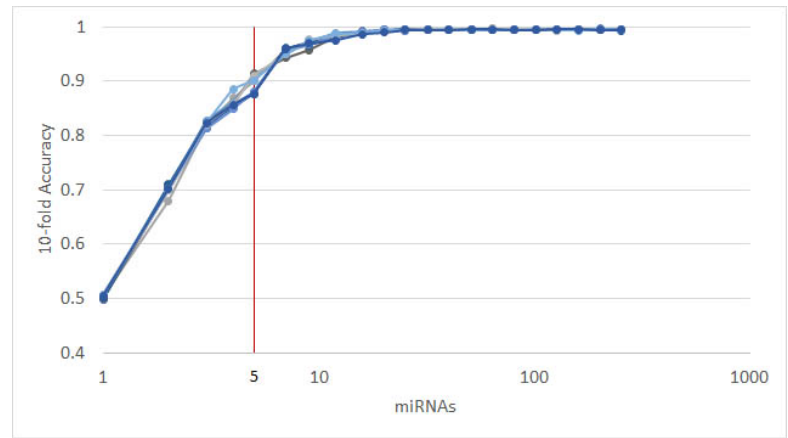
Figure 2. The results of 10 runs of the recursive ensemble feature selection for cancer type classification: The x axis cuts at 5 variables, where all runs cross the 90% average accuracy stop parameter (we computed the subsequent values as a